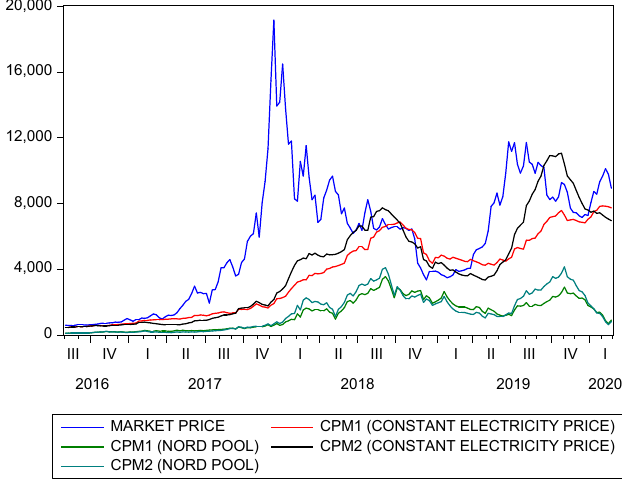
Figure 8. Bitcoin cost-of-production prices computed using both constant electricity prices and Nord Pool prices, together with the bitcoin market